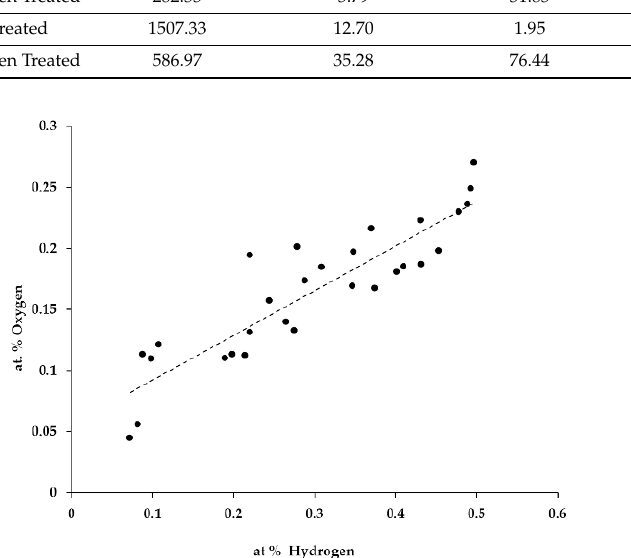
Figure 5. Plot showing at. % oxygen versus at. % hydrogen for all of the hydrogen heat-treated copper powders used in this study.